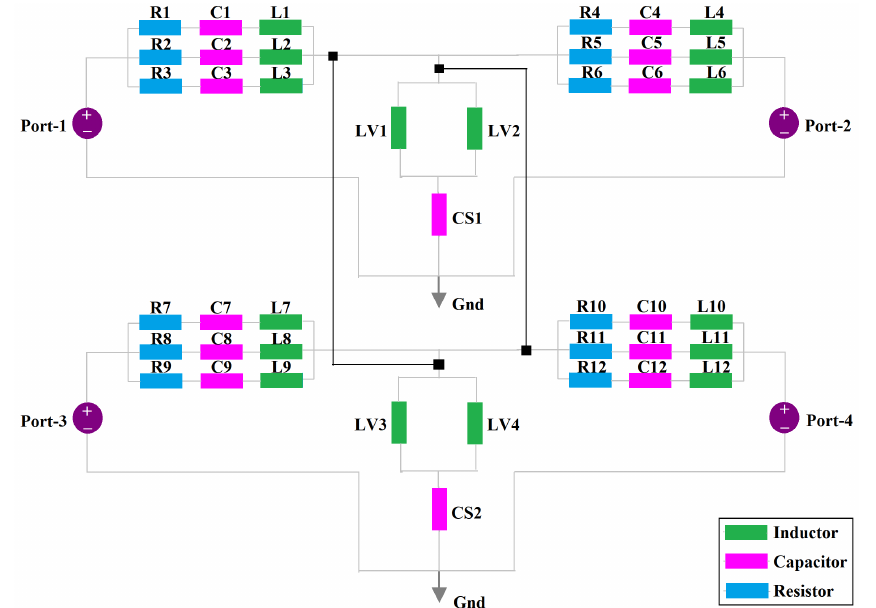
Figure 16. The equivalent circuit model (ECM) of the proposed four-element antenna configuration. The equivalent circuit parameters are: R1 = R4 = R7 = R10 = 59.35 Ω , R2 = R5 = R8 = R11 = 37.36 Ω , R3 = R6 = R9 = R12 = 89.11 Ω , C1 = C4 = C7 = C10 = 0.157 pF, C2 = C5 = C8 = C11 = 0.023 pF, C3 = C6 = C9 = C12 = 0.1017 pF, L1 = L4 = L7 = L10 = 6.98 nH, L2 = L5 = L8 = L11 = 15.3 nH, L3 = L6 = L9 = L12 = 4.78 nH, LV1 = LV2 = LV3 = LV4 = 0.25 nH, CS1 = CS2 = 1.5 pF, Z 0 = 50- Ω .